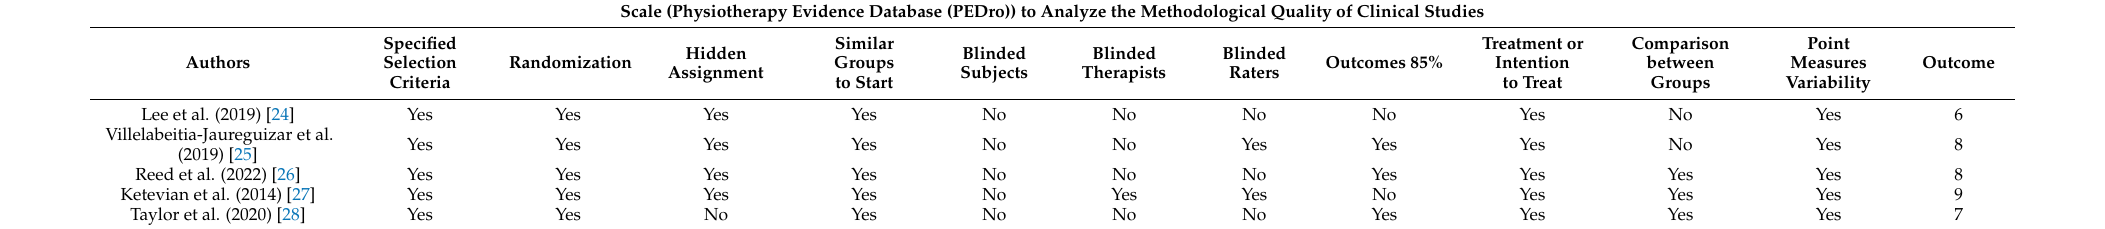
Table 2. Methodological quality evaluation of the clinical trials using the PEDro scale for randomized